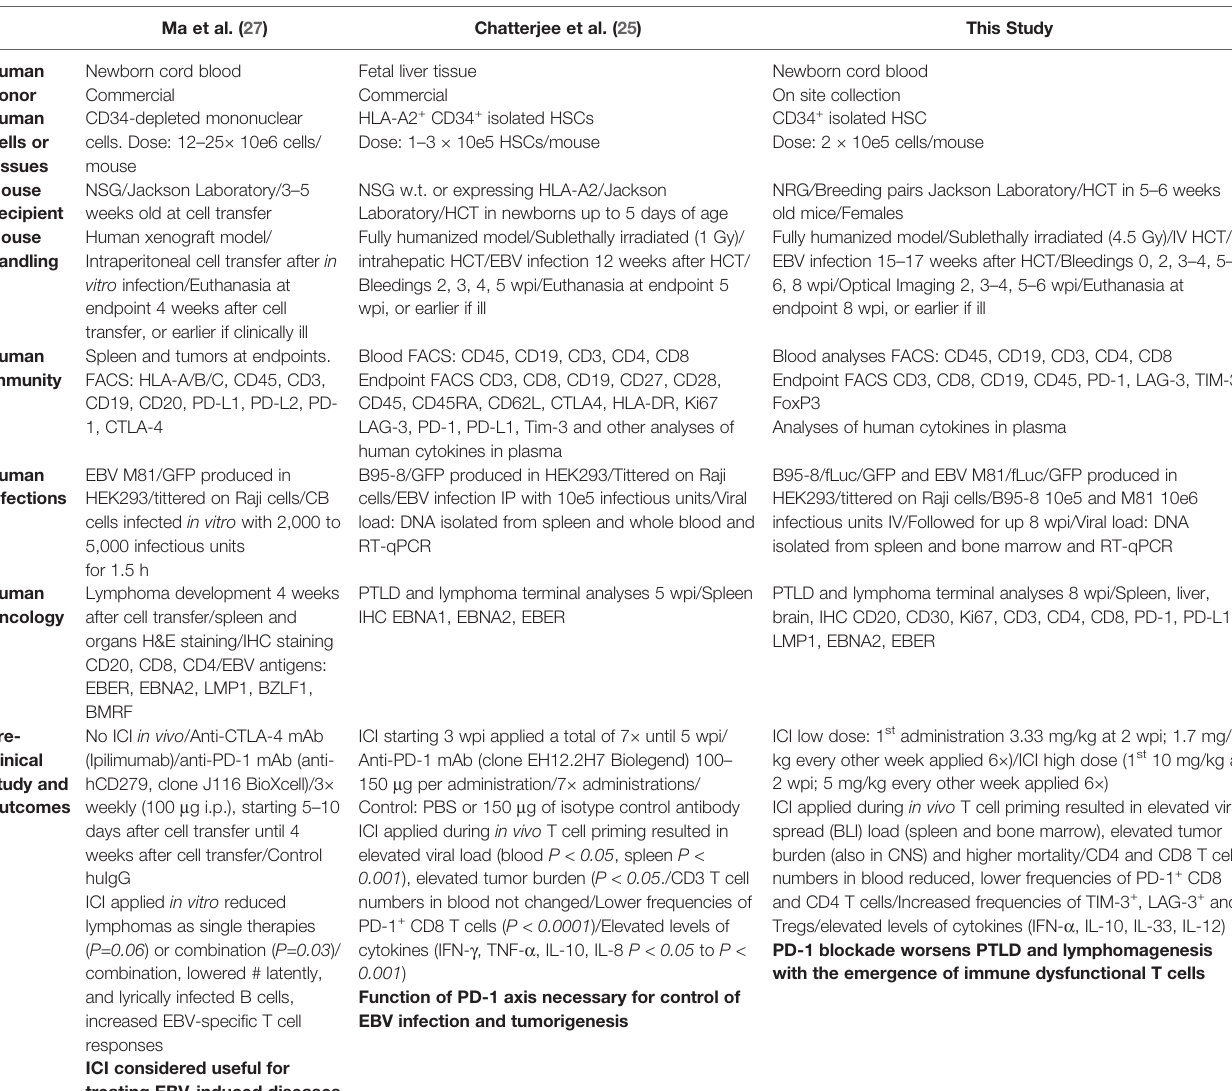
TABLE 1 | Summary of experimental approaches and conclusions from three different animal studies evaluating in vivo the effects of PD-1 blockade on EBV infection and tumor development. Ma et al.